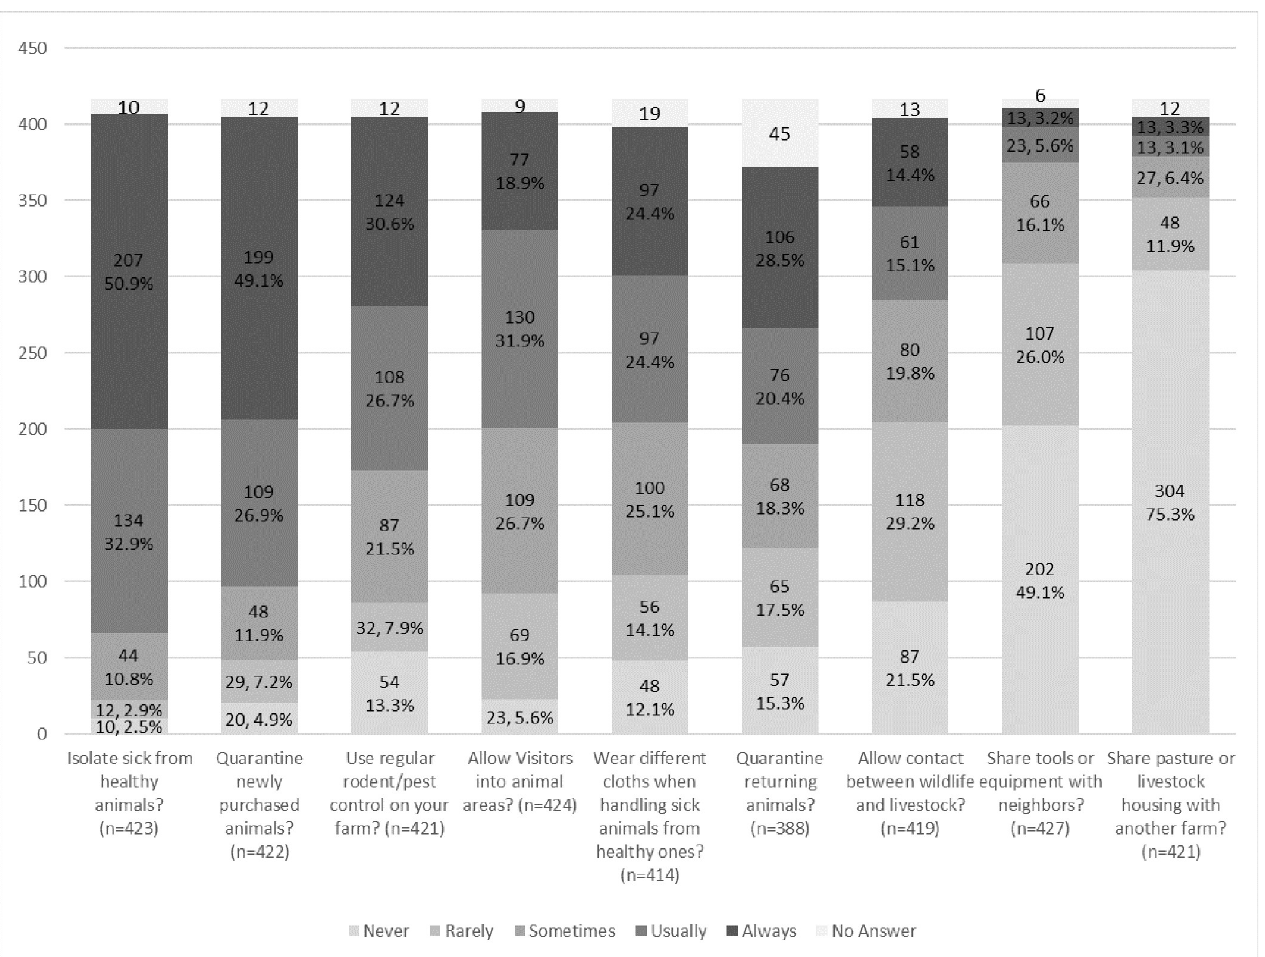
Fig 6. Biosecurity practices among small-scale livestock and poultry owners in 4 western states (Washington, California, Colorado and Oregon). Footnote : Proportions are given as the valid percentage: the percentage only of individuals who answered the question, and do not count no answers).